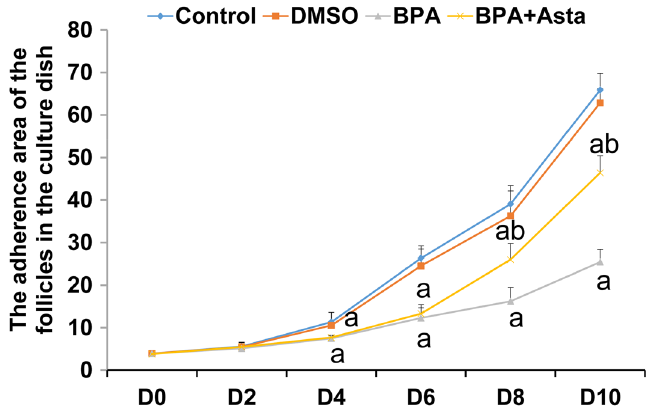
Figure 2. Analysis of adherence area of follicle growth (N = 10). Compared with control, a P < 0.05; and compared with BPA group, b P < 0.05.